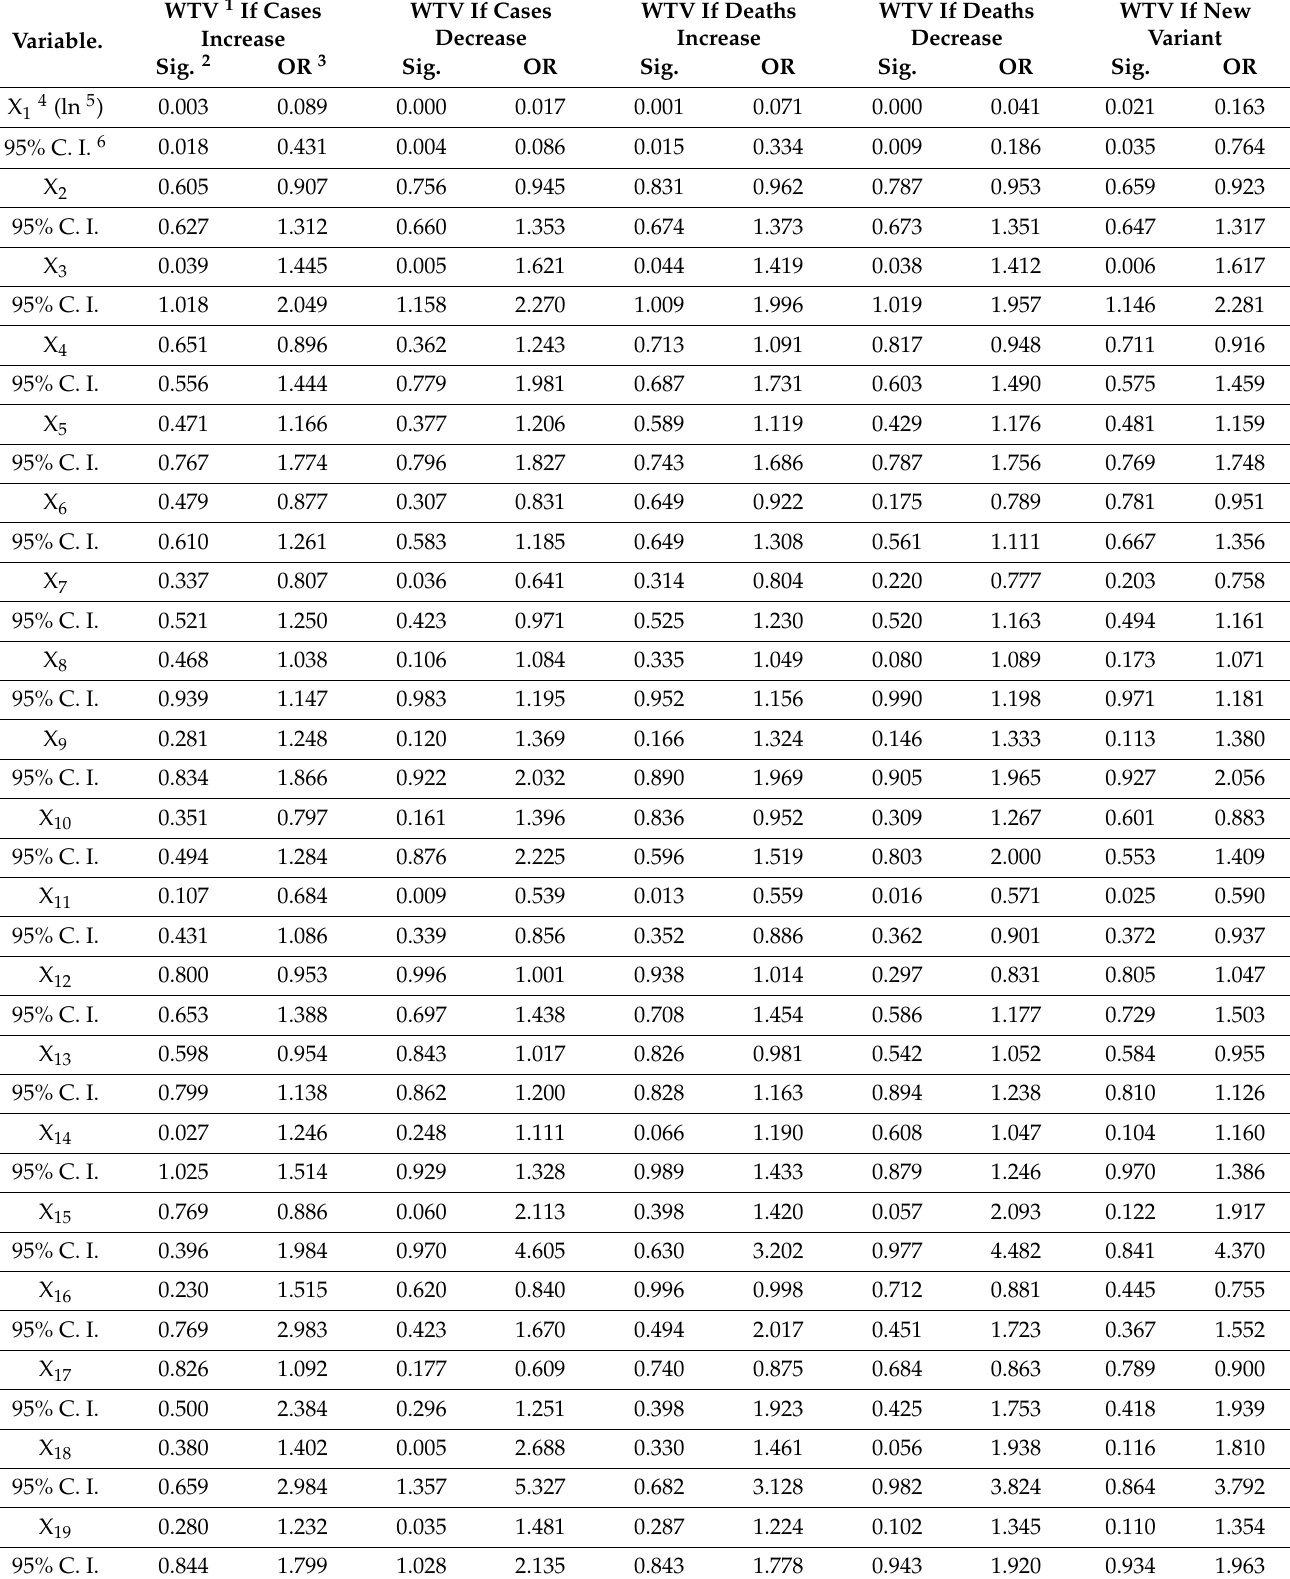
Table 2. Association between COVID-19 vaccine acceptance and the influential